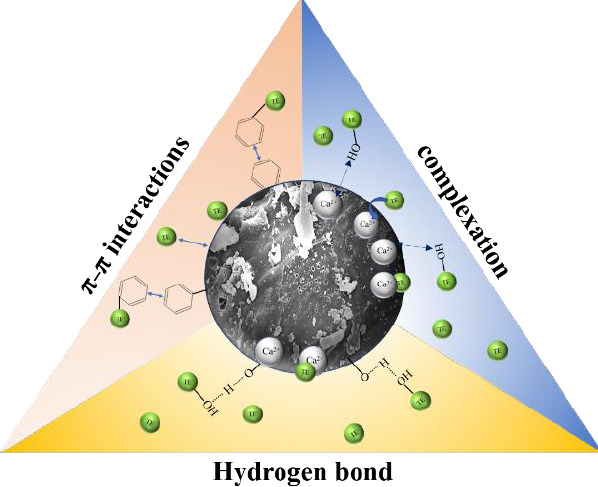
Figure 5. Schematic diagram of adsorption mechanism of TE by WHCBC.